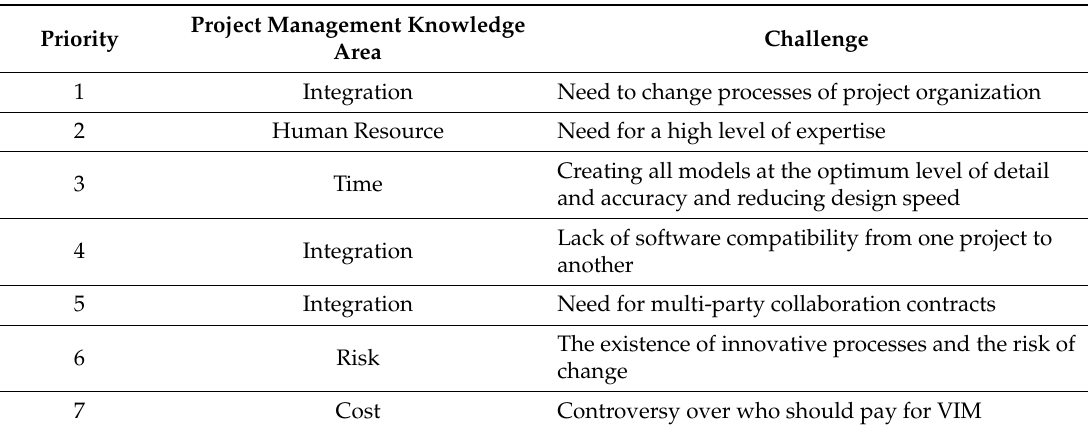
Table 13. Ranks of challenges of VIM